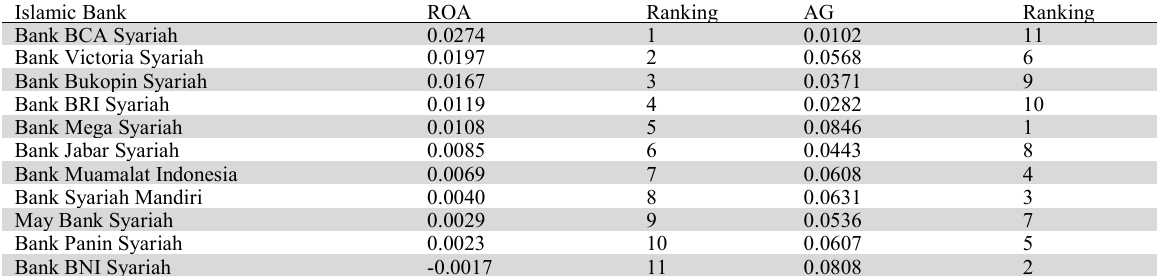
Ranking of competitive advantages of Islamic Banks in